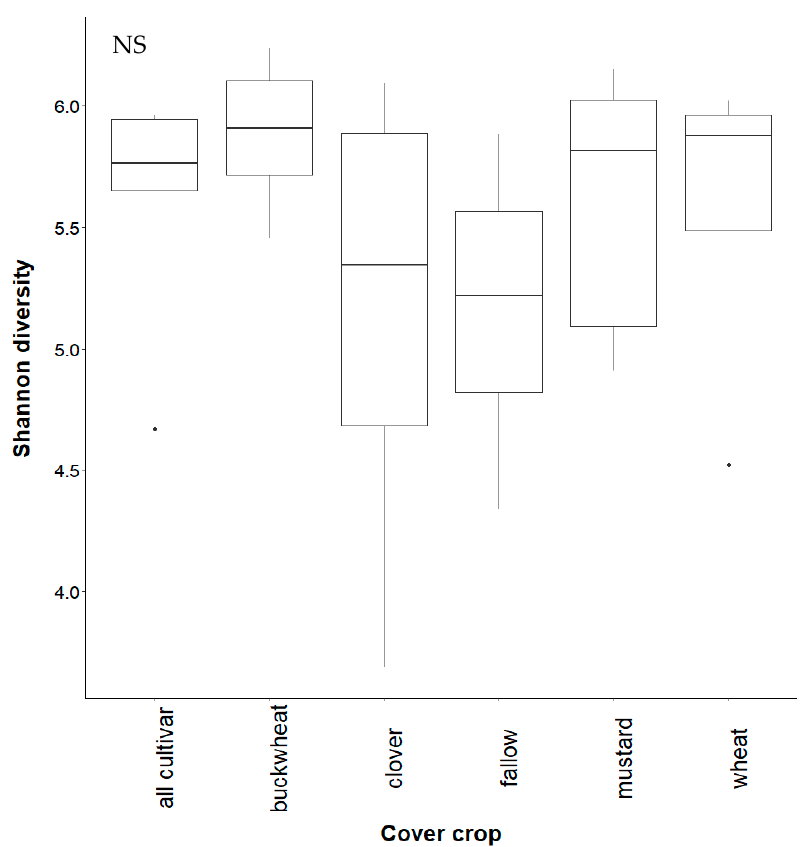
Figure A6. Shannon diversity of fungi in cultivar study soil. Treatments are all plants (“all cultivar”), buckwheat (“buckwheat”), crimson clover (“clover”), uninoculated fallow (“fallow”), white mustard (“mustard”), and wheatgrass (“wheat”). Fungal diversity did not vary significantly (NS) between treatments ( p = 0.531). Table A1. Site information and soil physiochemical properties adopted from Watson et al. (2018) [65].